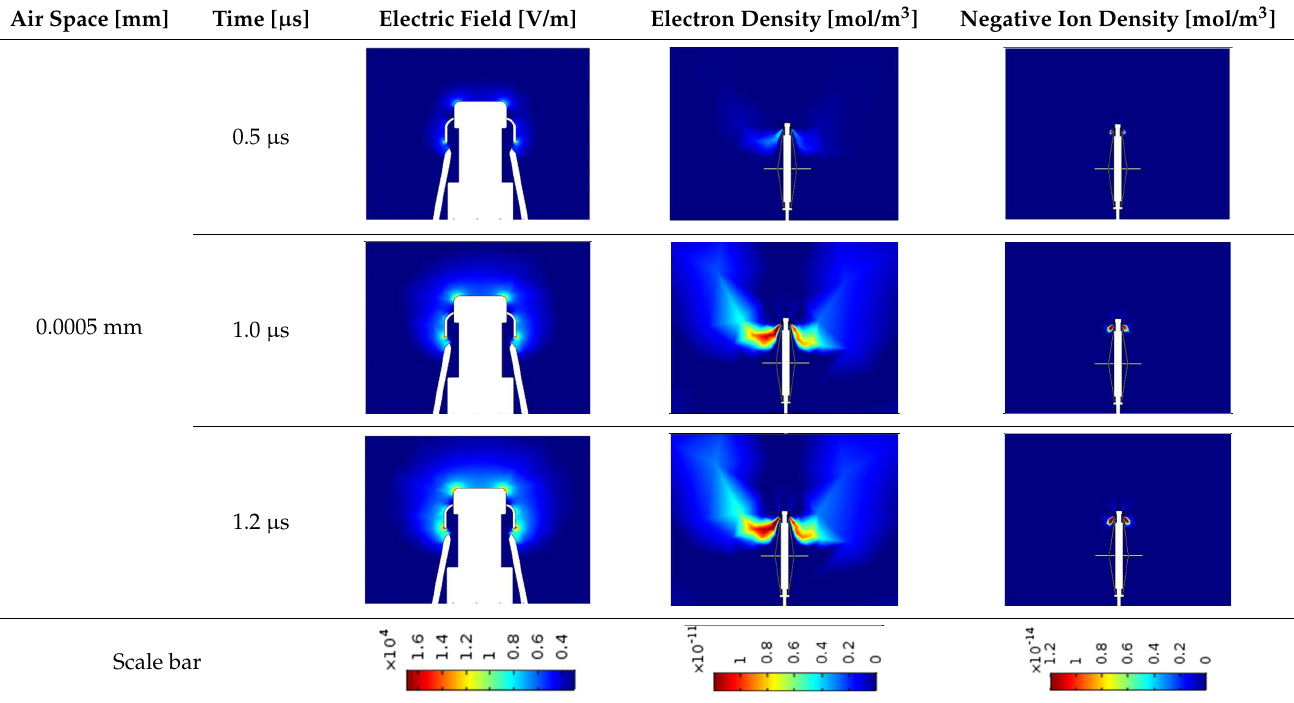
Figure 4. Negative and positive ion density as a function of time steps.